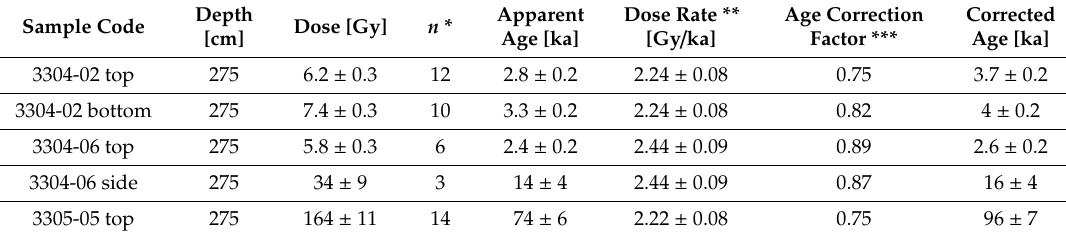
Table 4. Sample data, equivalent dose, dose rate estimates, and resulting luminescence